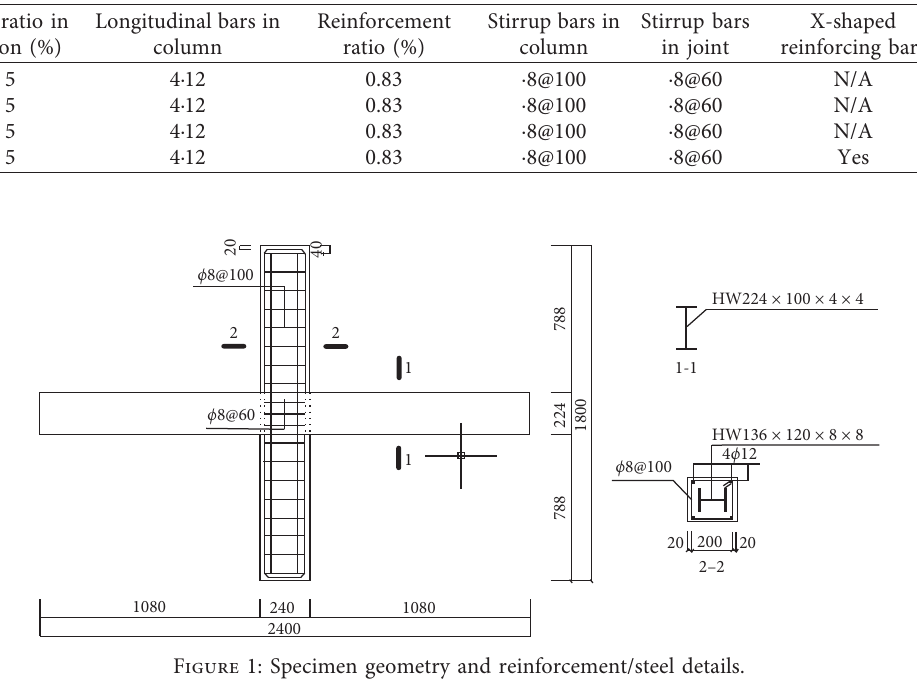
Table 2: Cross section and steel reinforcement details.